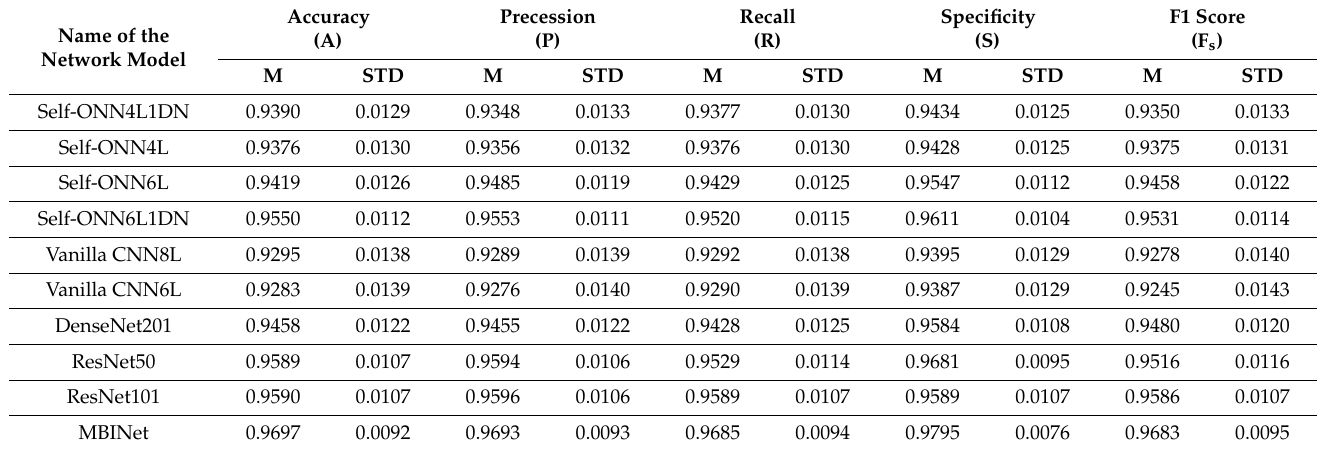
Table 5. Quantitative assessments of all models. Bold represents the best-performing model.